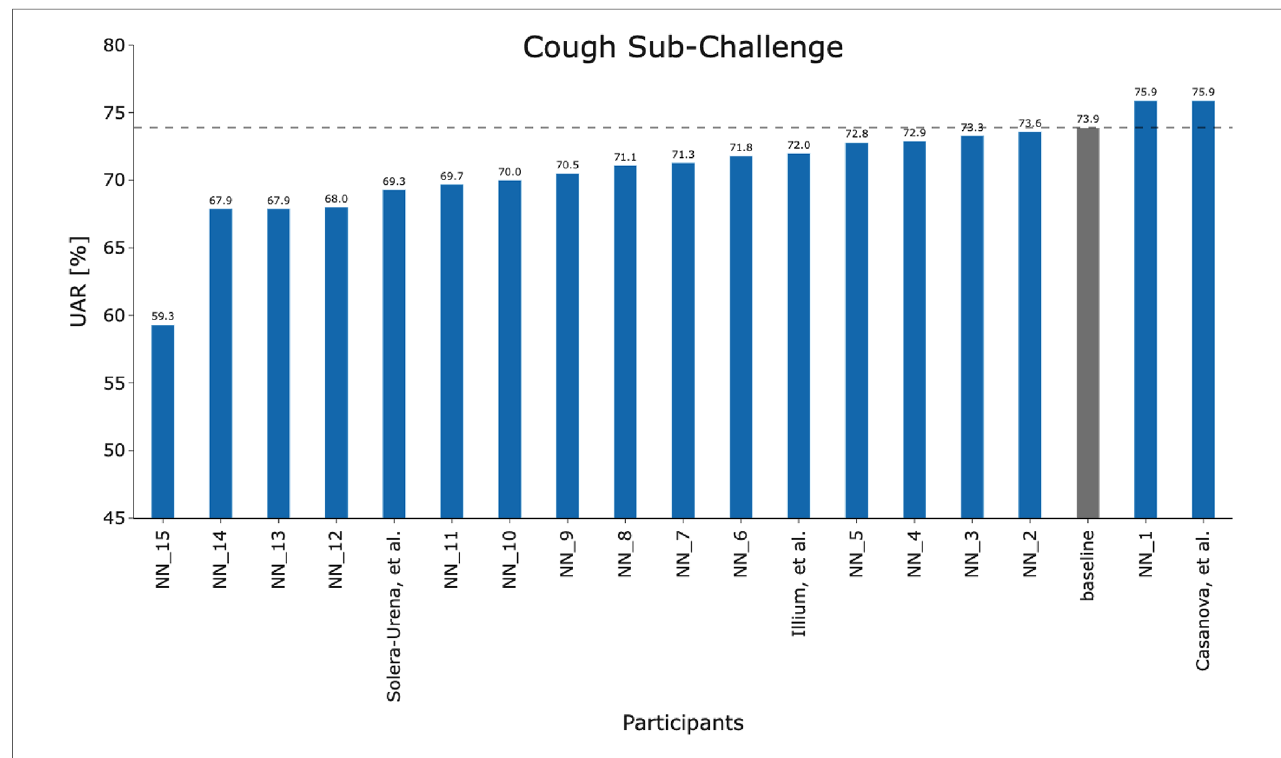
FIGURE 2 Team performance on the held out test set for the COVID-19 Cough Sub-Challenge.